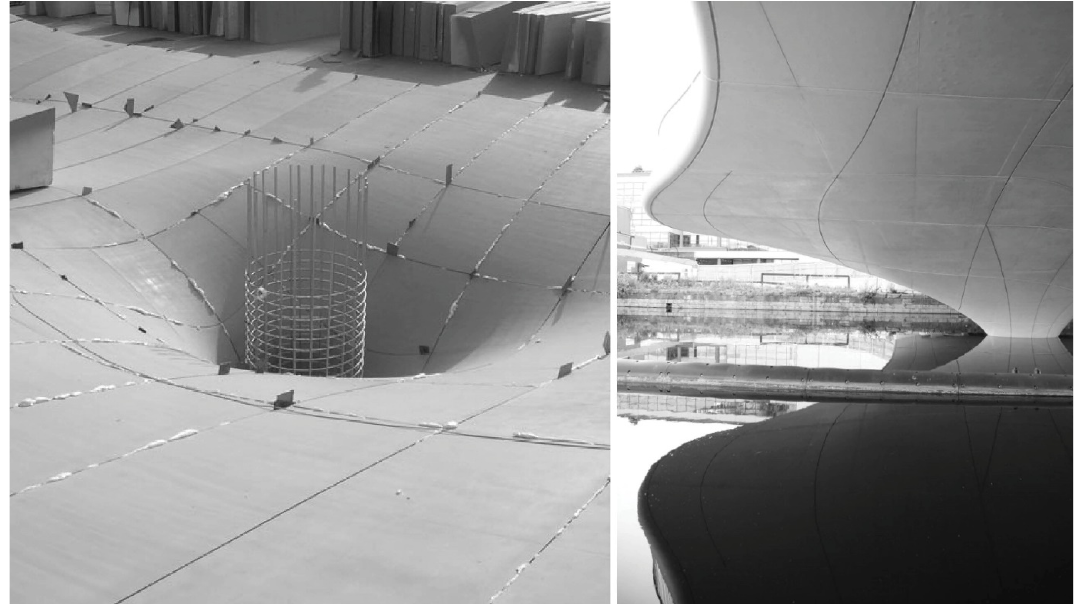
Figure 1. (Left) Finalized CNC milled and assembled formwork for casting. (Right) View under the Spencer Dock Bridge by Amanda Levete Architects, Dublin, 2012